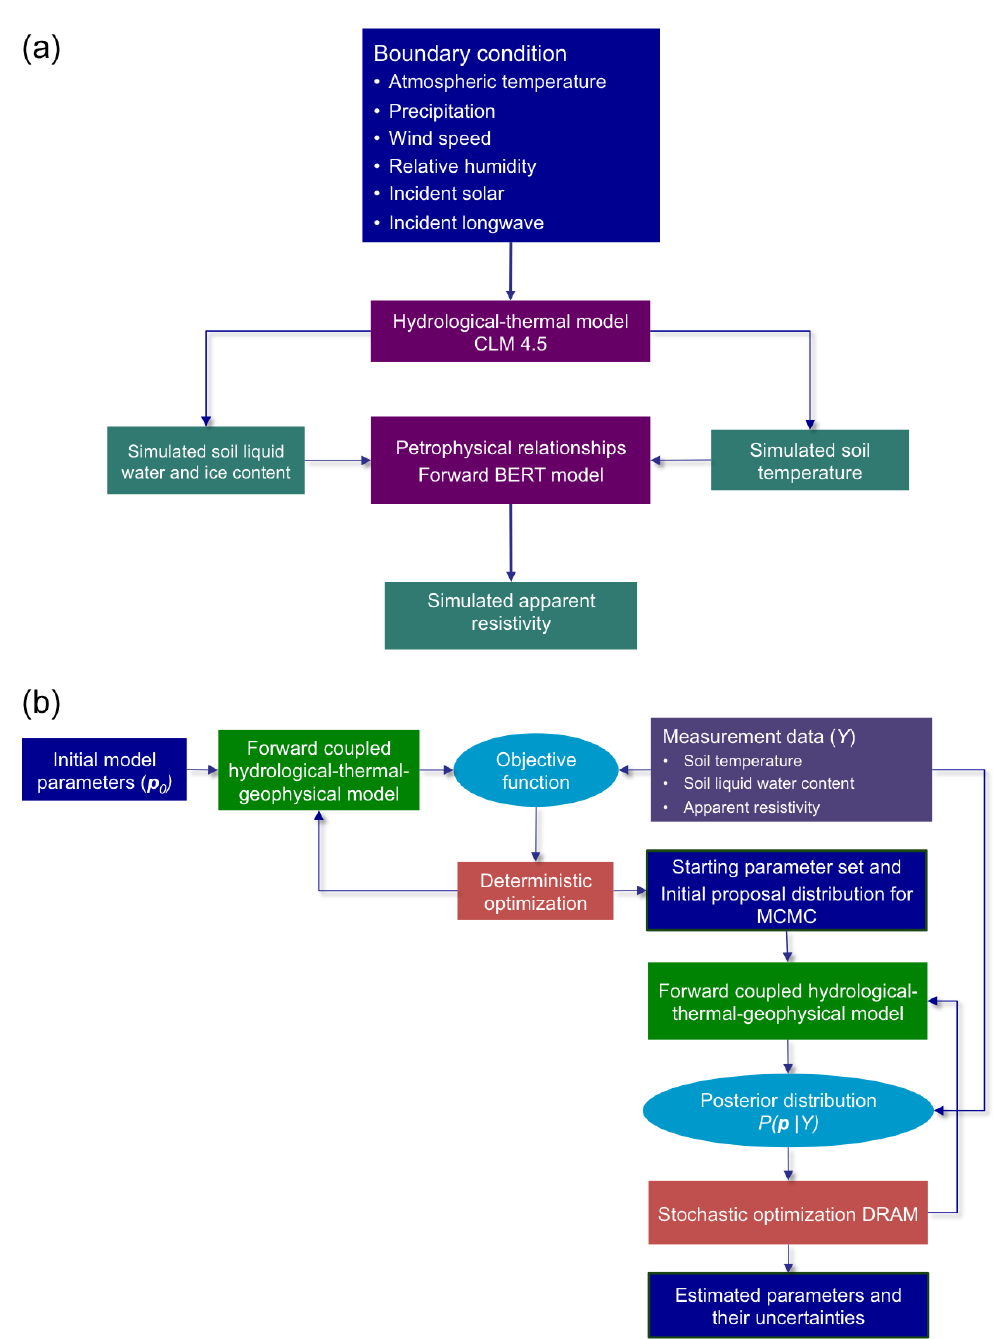
Figure 1. (a) Forward coupled hydrological–thermal–geophysical model that considers soil liquid/ice water content, temperature and appar- ent resistivity. (b) The two-stage inversion scheme combines deterministic and stochastic optimization algorithms to estimate the PDFs of desired model parameters ( p ), which include the OC content (scenarios 1–9), sand content (scenarios 8 and 9) and petrophysical parameters (scenarios 8 and 9) (see Table 2). The scheme permits flexibly using single or multiple types of data for inversion. The forward